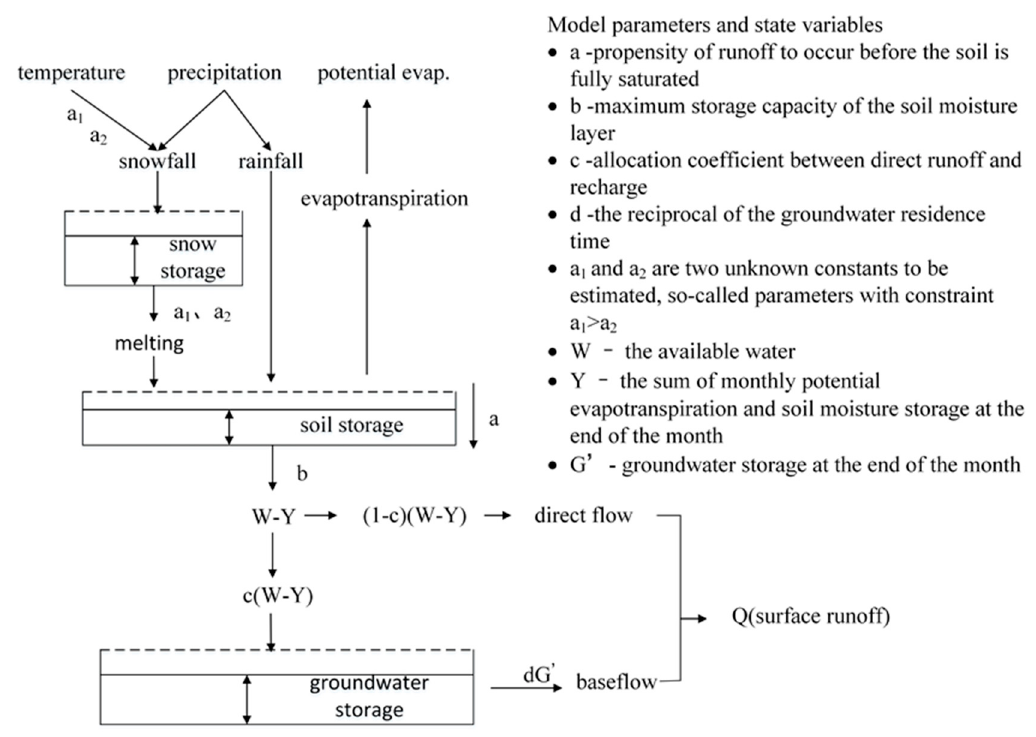
Figure 1. Water partitions in the improved ABCD model.